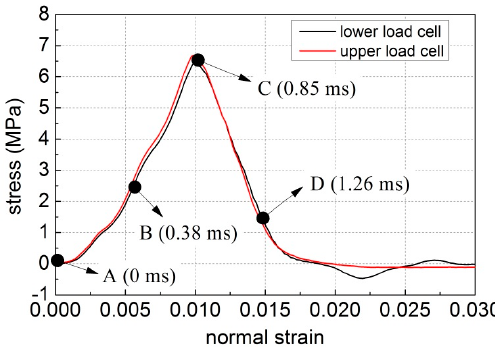
Figure 10. Stress versus nominal strain profile of sample HH05mps2 at − 10 °C (A, B, C, and D denote specific moments, corresponding to time point 0, 0.38, 0.85 and 1.26 ms, respectively).